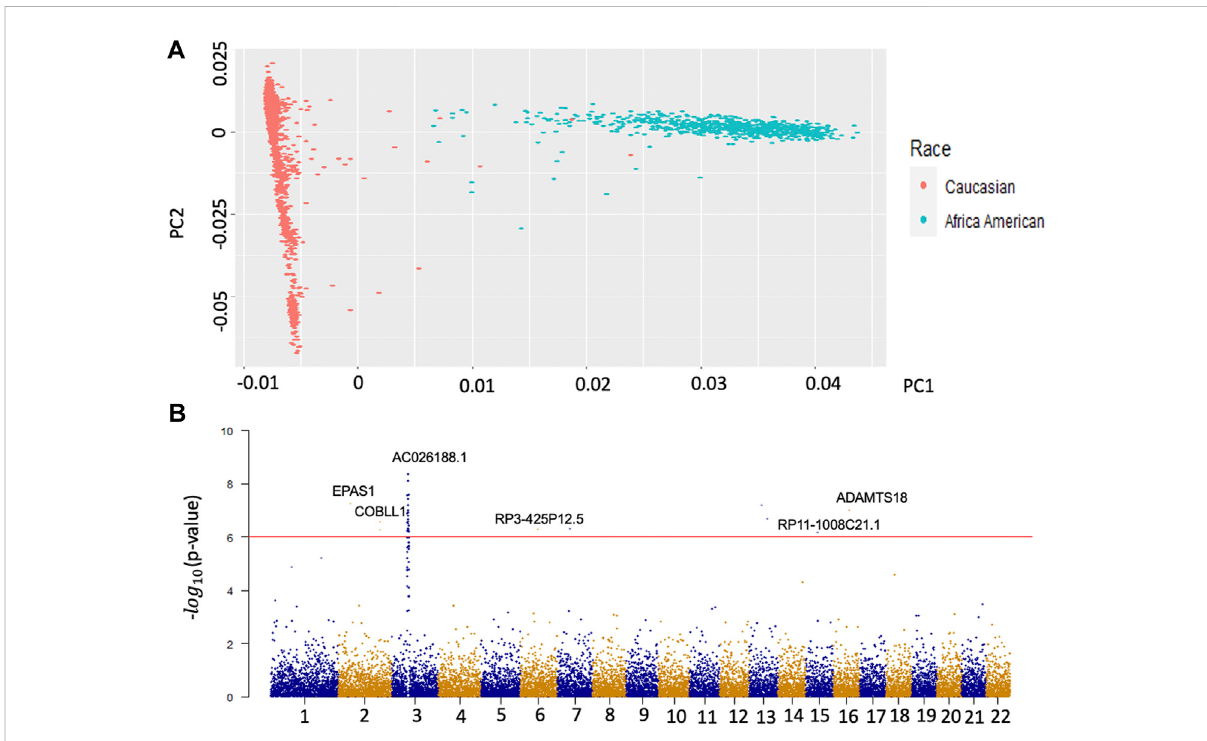
FIGURE 1 Population Strati fi cation oftwomain races andManhattan plots ofGWAS forOA.PanelA istheresult ofthe fi rsttwoprincipalcomponents. The red dots represent the population structure of Caucasians on the whole genotype matrix. The green dots represent the population structure of African Americans on the whole genotype matrix. Panel Bis the Manhattan plot of the results from the GWAS of Caucasian OA. The y axis represents – log ( p values) for the association of variants with OA. The horizontal red line represents the threshold for genome-wide signi fi